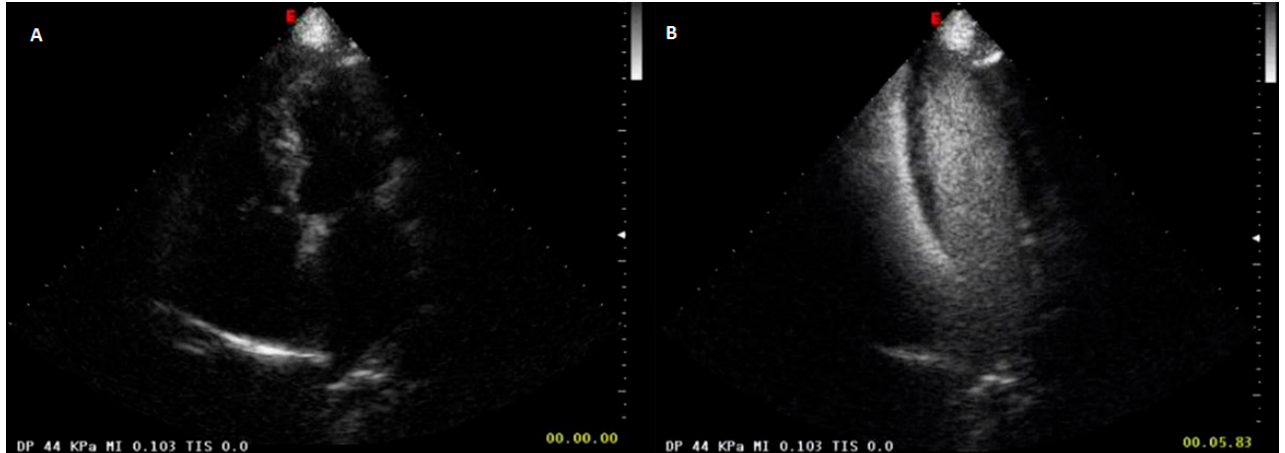
Figure 4. ( A ) US scan showing the four cardiac chambers before administration of contrast medium in a normal subject. ( B ) CEUS scan with SonoVue at 6 s after administration of contrast medium. All the four cardiac chambers are filled with contrast and therefore the double pulmonary circula- tion is completely